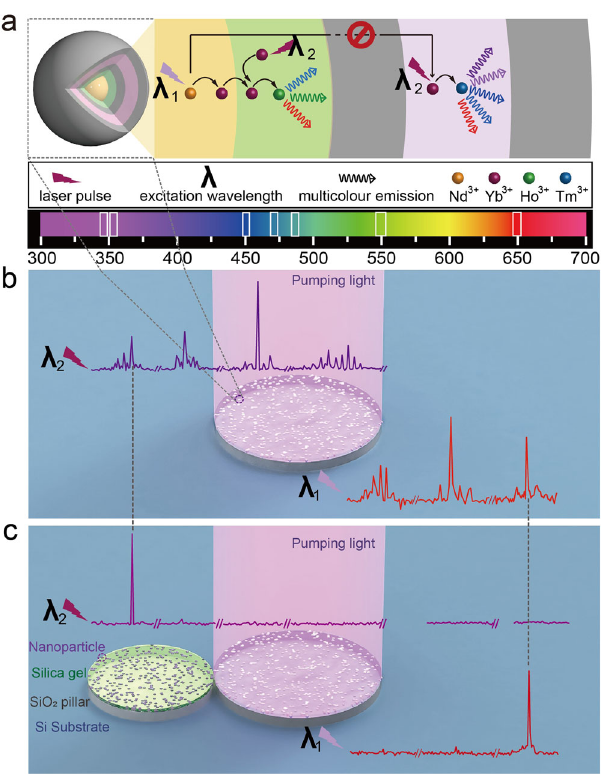
Fig. 1 Mode-switching concept of the UCNCs-based PMs laser. a Illustration of Ln 3 + -doped multi-shell nanocrystals with two distinct energy transfer paths under the excitation of λ 1 and λ 2 lasers. The distinct layers are highlighted by different colors. b An isolated UCNCs-based microdisk simultaneously supports multimode lasing emission with the emission wavelengths spanning over a wide spectral range. c UCNCs-based PMs structure is used to achieve dual-wavelength switchable single-mode laser under λ 1 / λ 2 pumping across an extremely wide spectral